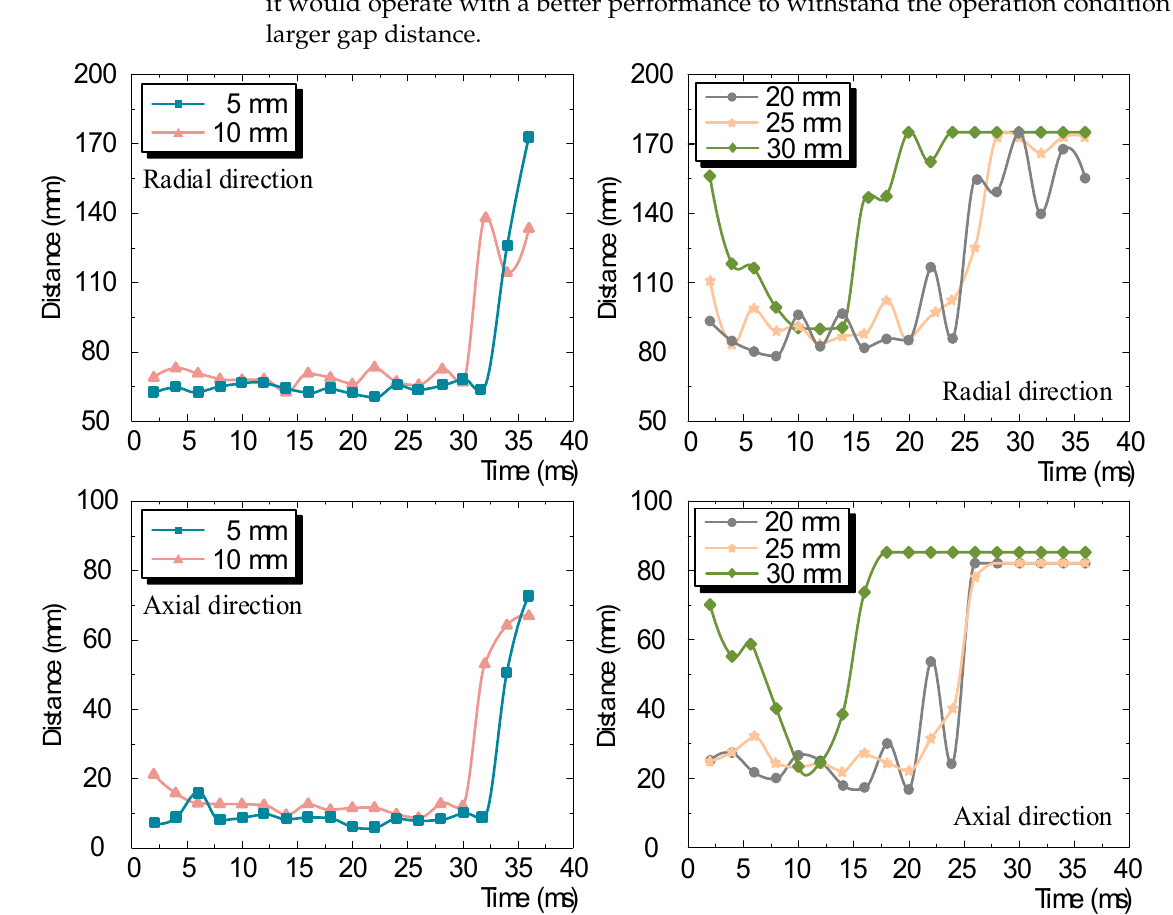
Figure 12. A comparison of arc diffusion under different gap distances between 5 mm and 30 mm.